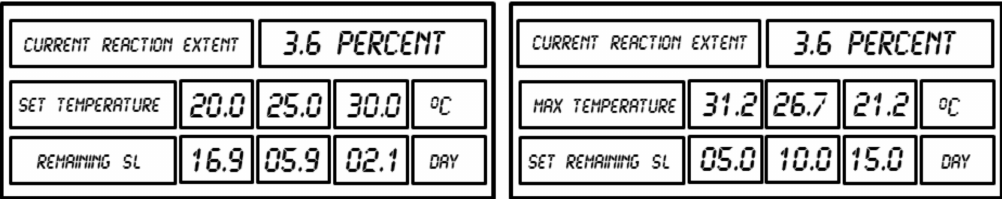
Figure 13. Display of the shelf life remaining for the sample with a deterioration progress of 3.6% at the user set temperature (left) or the maximal isothermal temperature for the shelf life remaining time (right) set by the